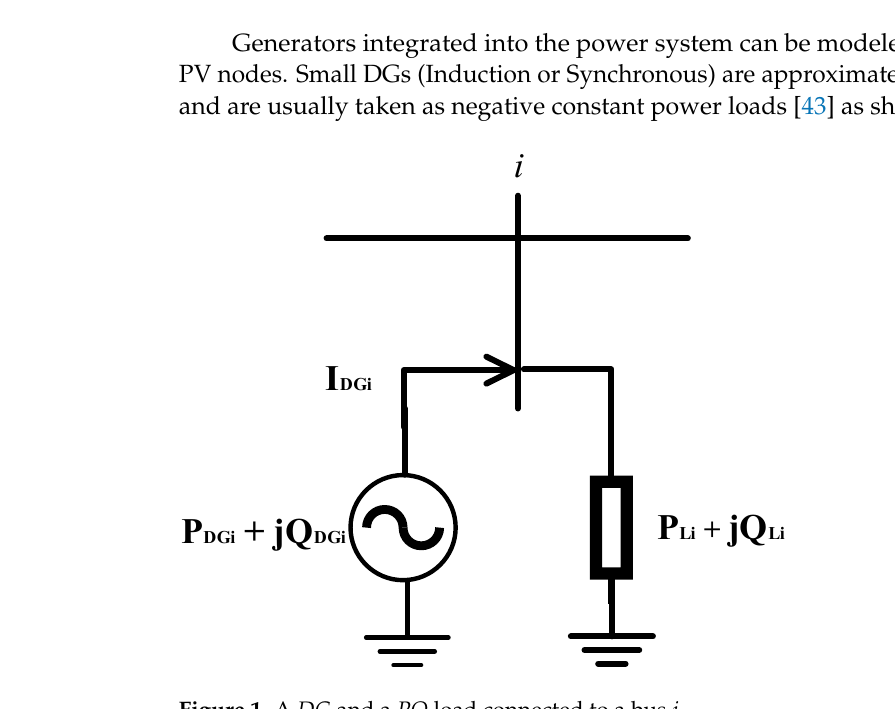
V i ∟ϴ Grid Figure 2. Circuit Diagram of power converter interface. 3.2. Type 2 DG—Power Converter Interface Model Real and reactive power are both added to the power system by the synchronous generator. A PQ node is modeled as the synchronous generator when it is used in power